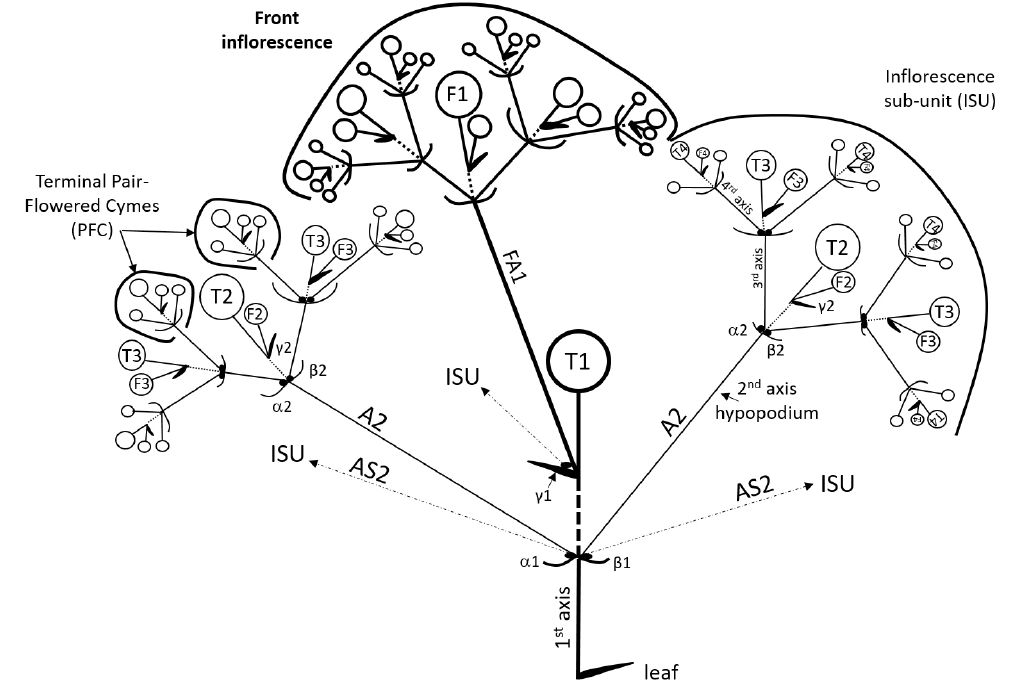
Fig. 2. Schema of the inflorescence of Bopopia parviflora Munzinger & J.R.Morel gen. et sp. nov., an indeterminate thyrse . Only four axes are represented on this schema (while up to 5 were seen on herbarium